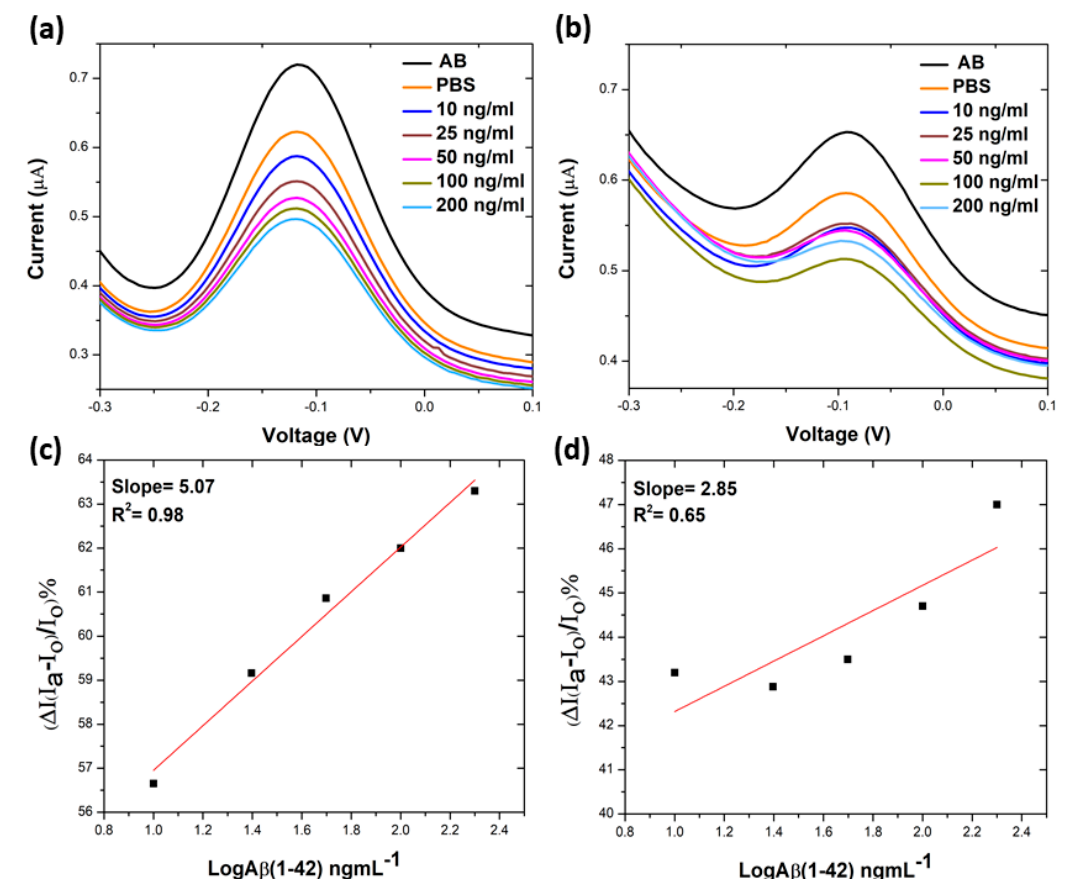
Figure 4. Differential pulse voltammetry (DPV) results for A β (1-42) peptide sensors made from amino-functionalised substrates using different numbers of reduction scans. ( a , b ) three and five scans; ( c , d ) corresponding calibration curves of %IR (I (I a – I o ) / I o ) %) (percentage current reduction) against log A β (1-42) concentrations.